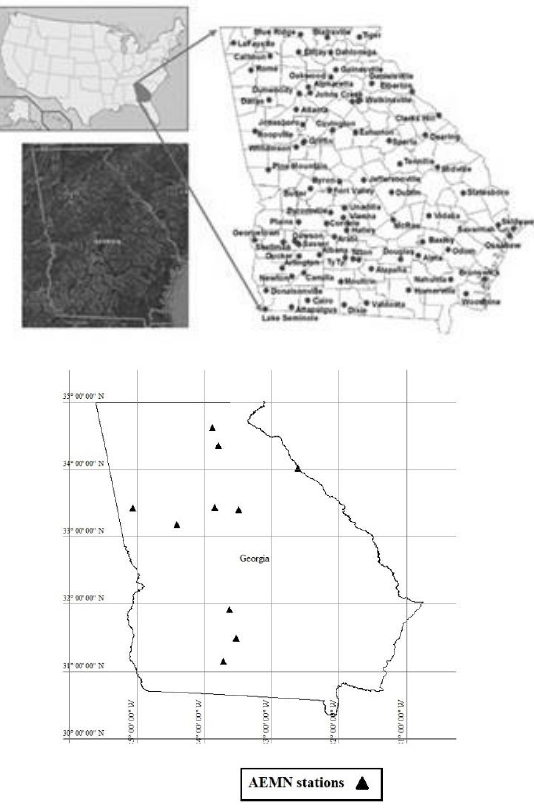
Figure 1. Regions of study